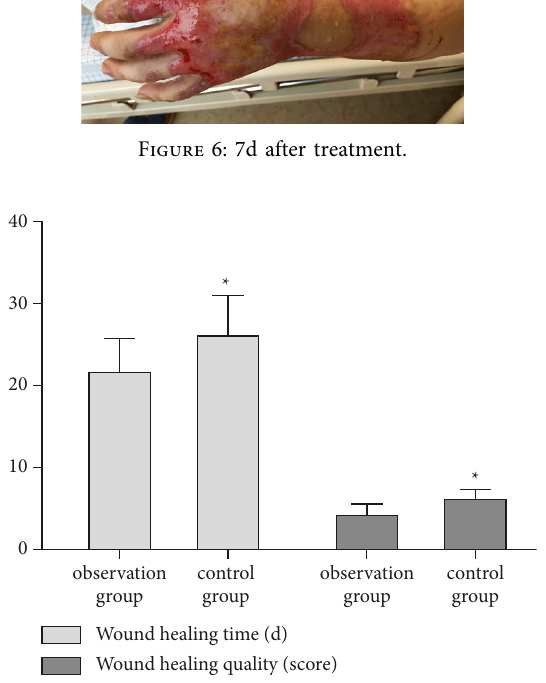
Figure 7: Comparison of wound repair rate and wound healing quality between the two groups.